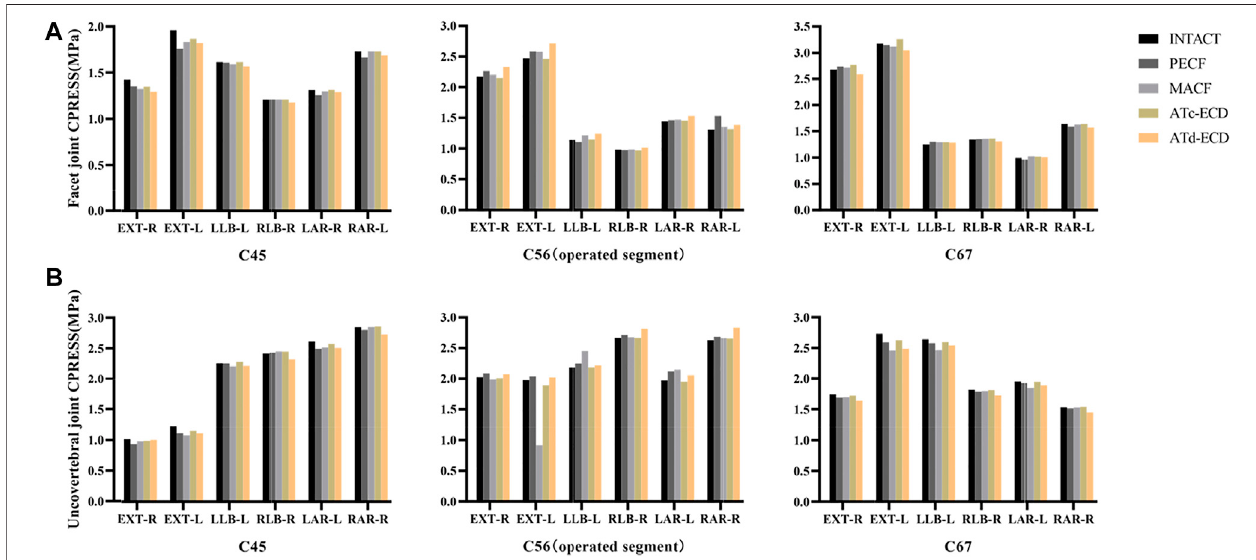
FIGURE 7 | The FJs CPRESS and UJs CPRESS of C4 – C5, C5 – C6, C6 – C7 in intact model and surgical models. (A) -R, right facet joint; -L, left facet joint. (B) -R, right uncovertebral joint; -L, left uncovertebral joint. Ipsilateral uncovertebral joint and facet joint bear major pressure during lateral bending, whereas Ipsilateral uncovertebraljointandcontralateralfacetjointbearmajorpressureduringaxialrotation.FLE, fl exion;EXT,extension;LLB,leftlateralbending;RLB,rightlateralbending; LAR, left axial rotation; RAR, right axial rotation.